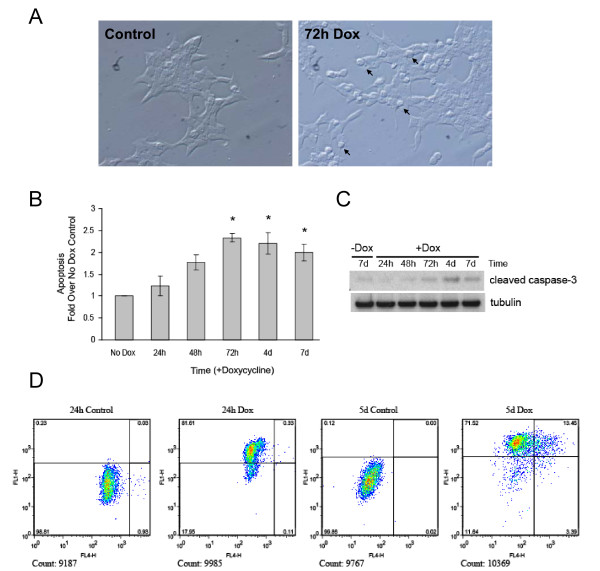
Expression of insulin 2 (C96Y)-EGFP induces apoptosis. A. Clone #4S2 cells were treated or not with 2 μg/ml doxycycline for 72 h, fixed and imaged by differential interference contrast microscopy. Potentially apoptotic cells with a rounded morphology are indicated (arrows). B-D. Clone #4S2 cells were treated with 2 μg/ml doxycycline for the indicated times. B. Following the treatments, the cells were lysed and apoptosis was measured using a cell death detection ELISA kit (Roche) as described in the methods. Shown are the mean ± SE of 4 independent experiments. *p < 0.05. C. Cells were washed in PBS, lysed and equal amounts of protein were resolved by NuPAGE and immunoblotted using antibodies to cleaved caspase-3 and γ-tubulin. D. Cells were fixed and labeled with Alexa Fluor 647 dye-labeled anti-BrdU antibody. Cells were analyzed by flow cytometry; the FL1 laser excites GFP, whereas FL4 excites Fluor 647. Cells in the upper left and right quadrants were classified as mutant insulin expressing, cells in the upper and lower right quadrants were classified as apoptotic. The total number of cells examined is shown below each chart, and the percentage of cells in each quadrant is indicated.